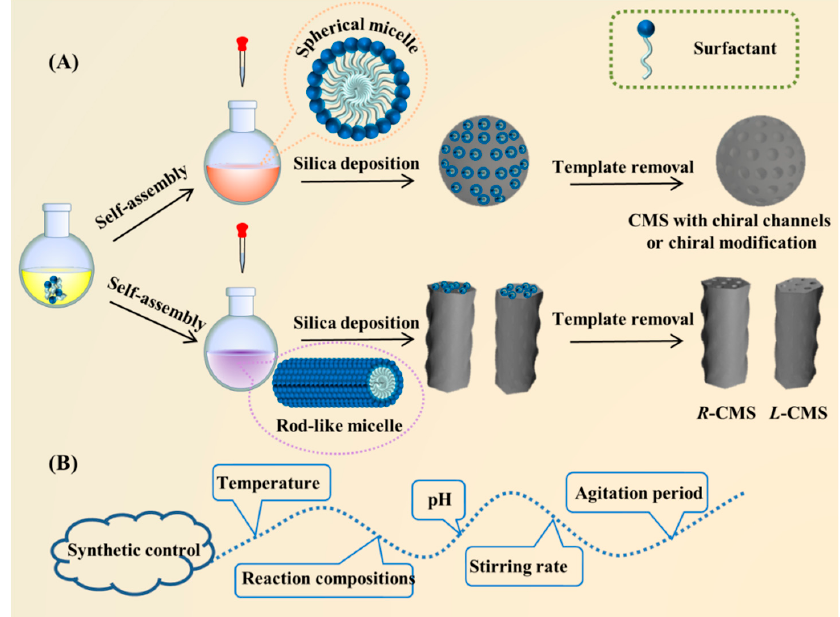
Figure 1. ( A ) Schematic diagram of CMS synthesis by surfactants; ( B ) Factors contributing to the synthetic control of CMS. Credit: original figure.